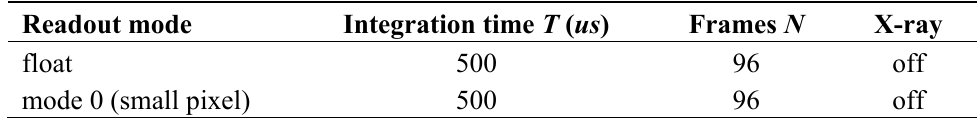
Table 2. Noise level experimental